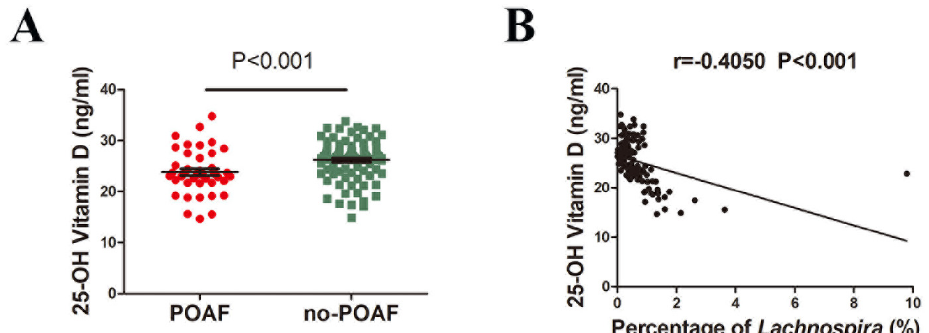
Figure 3. Correlations between Lachnospira and plasma Vitamin D levels. ( A ) Lower plasma 25- hydroxy vitamin D levels were found in the POAF group than the no-POAF group. p < 0.001 by unpaired t test. ( B ) Negative correlation between the plasma 25-hydroxy vitamin D levels and Lachnospira (r = − 0.4050, p < 0.001 by Pearson correlation).